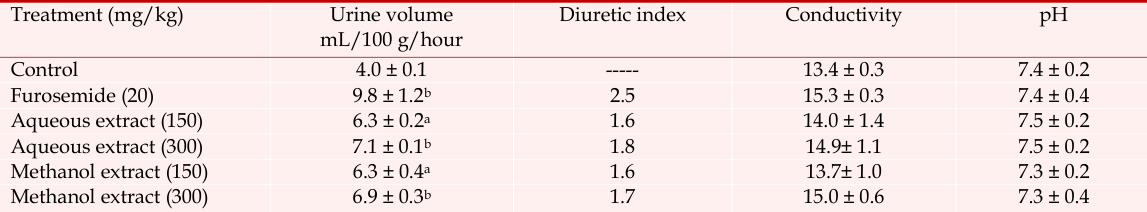
Effect of extracts of seeds of Caesalpinia bonduc on urinary volume, diuretic index, conductivity and pH Treatment (mg/kg)